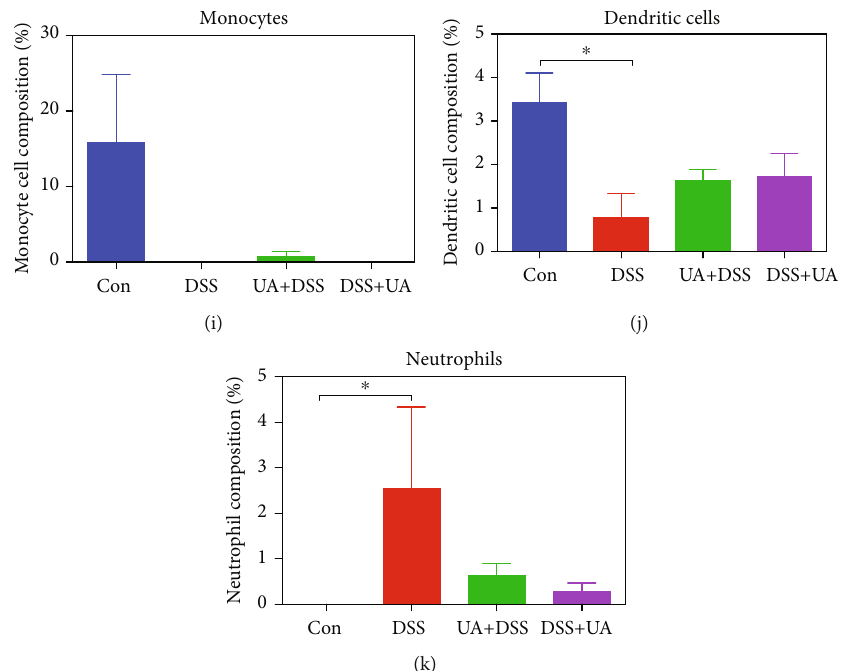
Figure 5: Composition of in fi ltrated immune cells among four UC experiment groups. (a) Fractions of 10 immune cells in Con, DSS, UA +DSS, and DSS +UA groups ( n = 3 each group). (b) The proportion of macrophage change in four experimental groups. (c) The proportion of CD4 T cells change in four experimental groups. (d) The proportion of NK cell change in four experimental groups. (e) The proportion of eosinophil change in four experimental groups. (f) The proportion of B cell change in four experimental groups. (g) The proportion of CD8 T cell change in four experimental groups. (h) The proportion of mast cell change in four experimental groups. (i) The proportion of monocyte cell change in four experimental groups. (j) The proportion of dendritic cell change in four experimental groups. (k) The proportion of neutrophil change in four experimental groups. Data represent the mean ± SEM of values per group. Statistically signi fi cant results in di ff erent groups are marked by ∗ P < 0 : 05 and ∗∗ P < 0 : 01 . There was no signi fi cant di ff erence in the unmarked